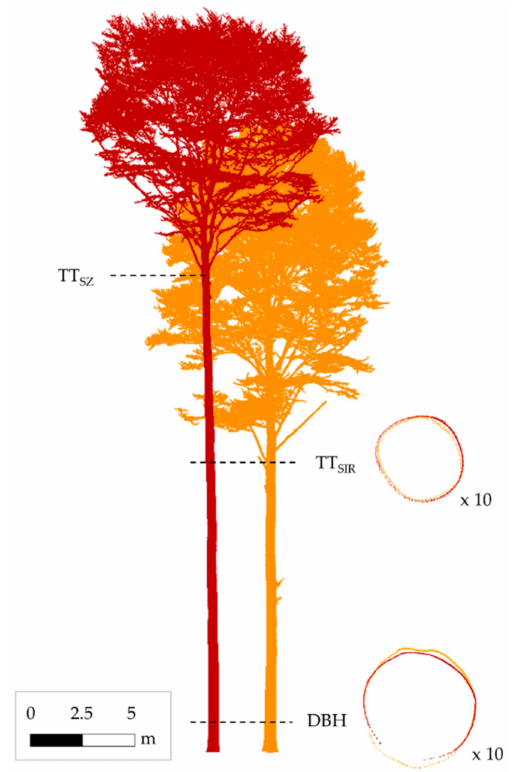
Figure 1. Filtered point clouds from terrestrial laser scanning (TLS) of two exemplary European beech trees with approximately the same total wood volume. The left tree (red) is a representative individual growing in a long-term unmanaged stand, Schattiner Zuschlag (SZ; diameter at breast height (DBH): 53.6 cm; tree height: 37.2 m; taper top height (TT): 23.4 m; total wood volume (V tot ): 6.5 m 3 ; wood volume of the branch-free trunk (V bft ): 3.6 m 3 ). The right tree (orange) is growing in an intensively managed stand, Sirksfelder Zuschlag (SIR; DBH: 56.1 cm; tree height: 31.7 m; TT: 13.9 m; V tot : 6.7 m 3 ; V bft : 2.4 m 3 ). The circles display the contours at DBH and at taper top height in SIR (red cycles: SZ; orange cycles: